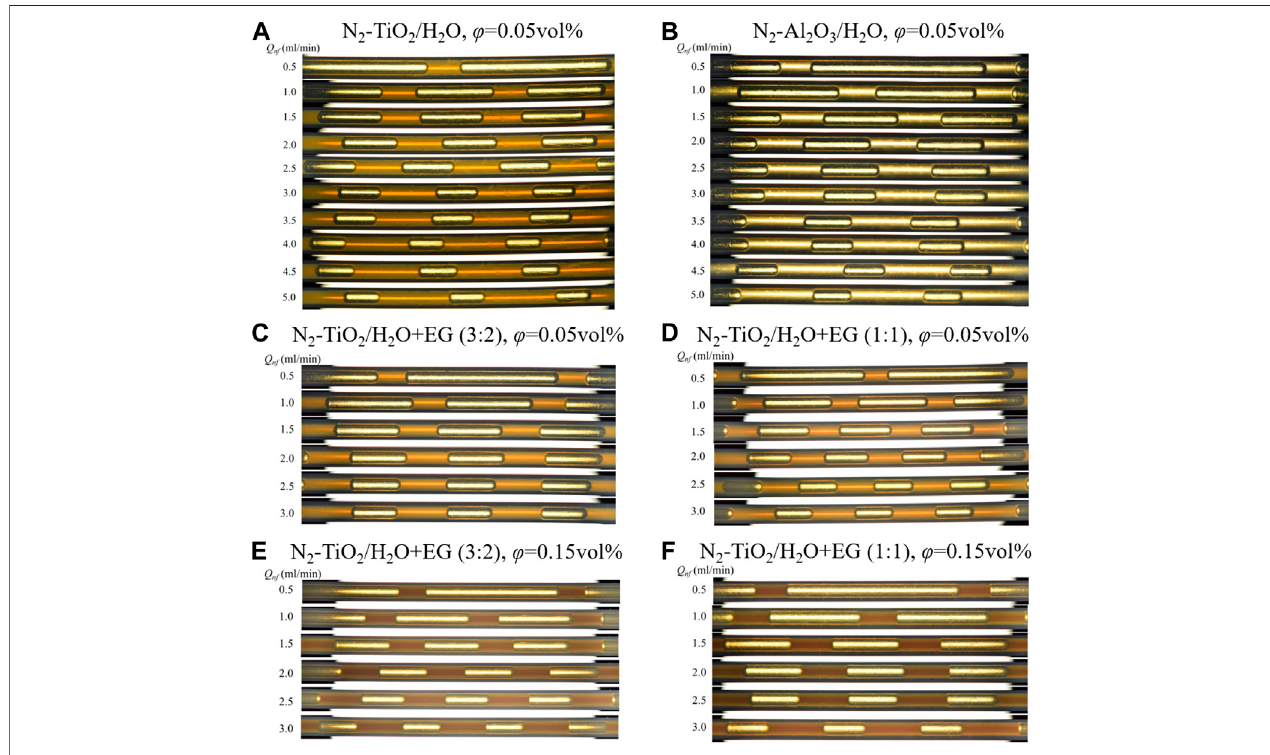
FIGURE 7 | Flow pattern of N 2 -nano fl uid slug fl ow in the PTFE microchannel ( d c (cid:1) 0.8 mm). The fl ow direction is from left to right, Q g (cid:1) 2.77 ml/min. (A) N 2 – TiO 2 / H 2 O, φ (cid:1) 0.05 vol%, θ (cid:1) 72.5 ° ; (B) N 2 – Al 2 O 3 /H 2 O, φ (cid:1) 0.05 vol%, θ (cid:1) 65.5 ° ; (C) N 2 – TiO 2 /H 2 O + EG (3:2), φ (cid:1) 0.05 vol%, θ (cid:1) 84.5 ° ; (D) N 2 – TiO 2 /H 2 O + EG (1:1), φ (cid:1) 0.05 vol%, θ (cid:1) 87.5 ° ; (E)